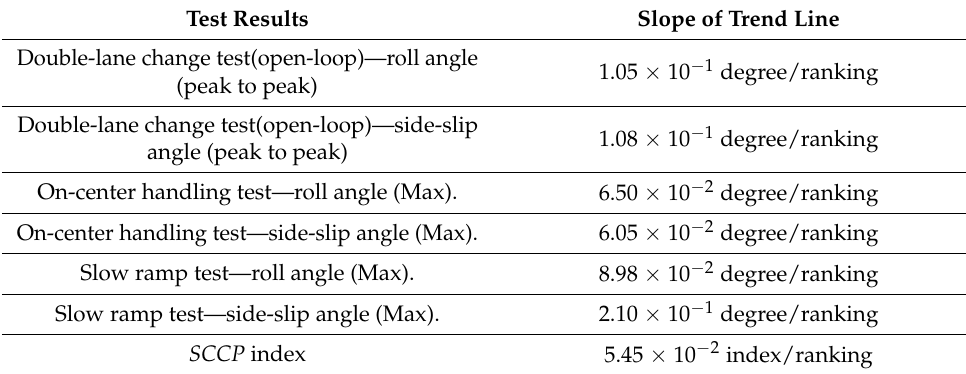
Table 11. Slope of the suspension and tire cornering performance index ( STCT